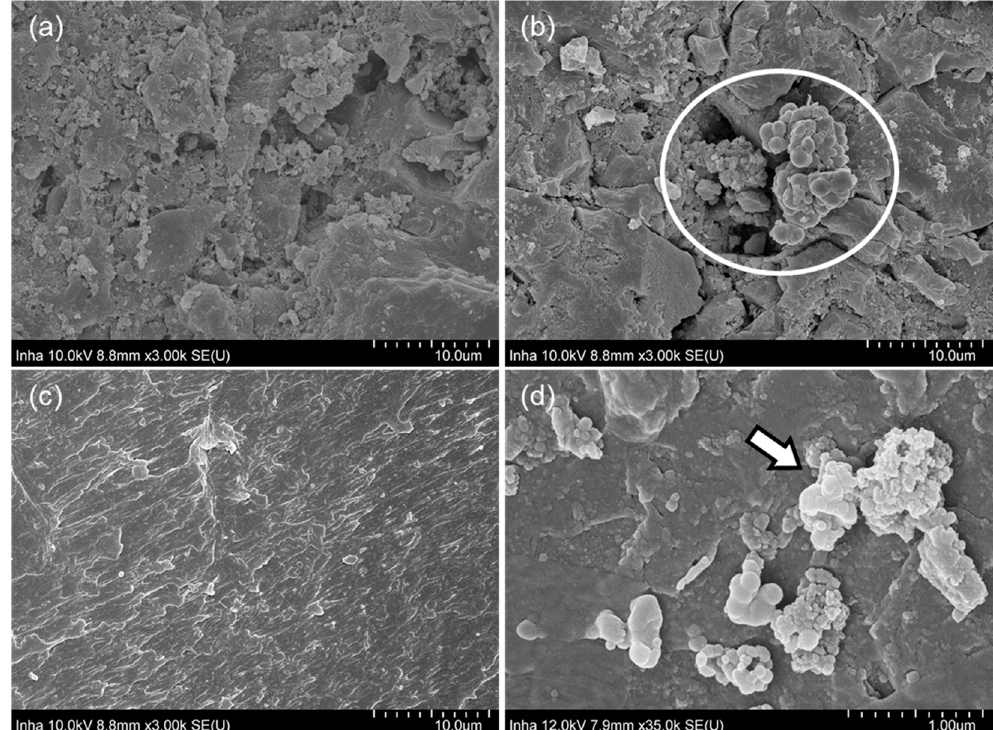
Figure 4. The SEM images of surface on ( a ) GAC, ( b ) used GAC, ( c ) ABS, and ( d ) used ABS media in AFMBR. ( b , d ) show some anaerobic microorganisms which adhered and were grown on the surface of each media.